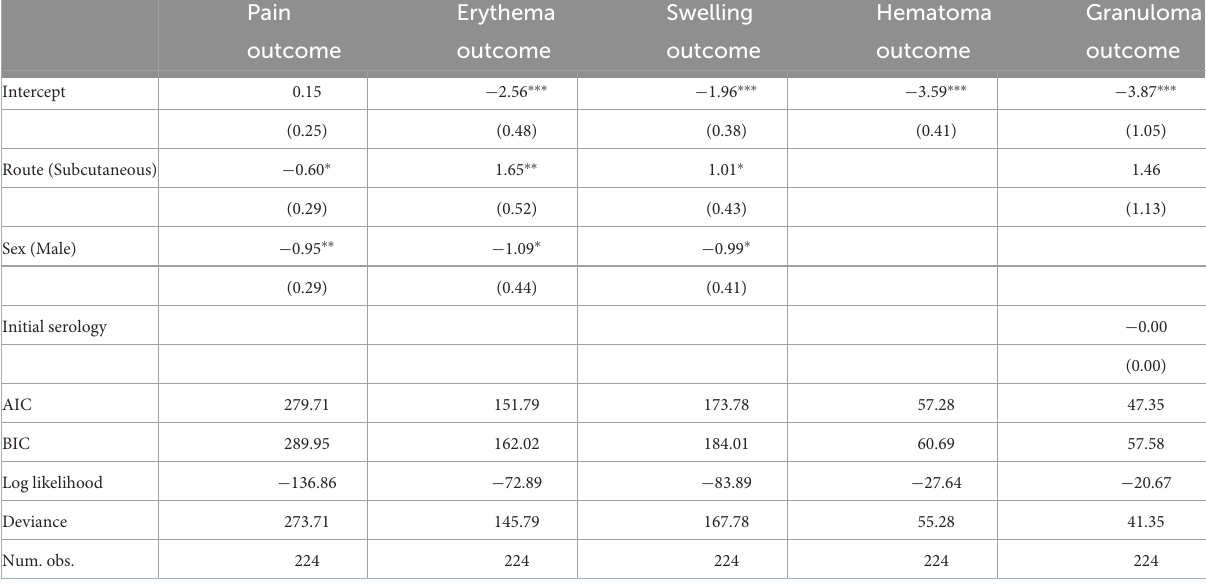
TABLE 3 Multivariate logistic regression with pain, erythema, swelling, hematoma, and granuloma considered as the targets.